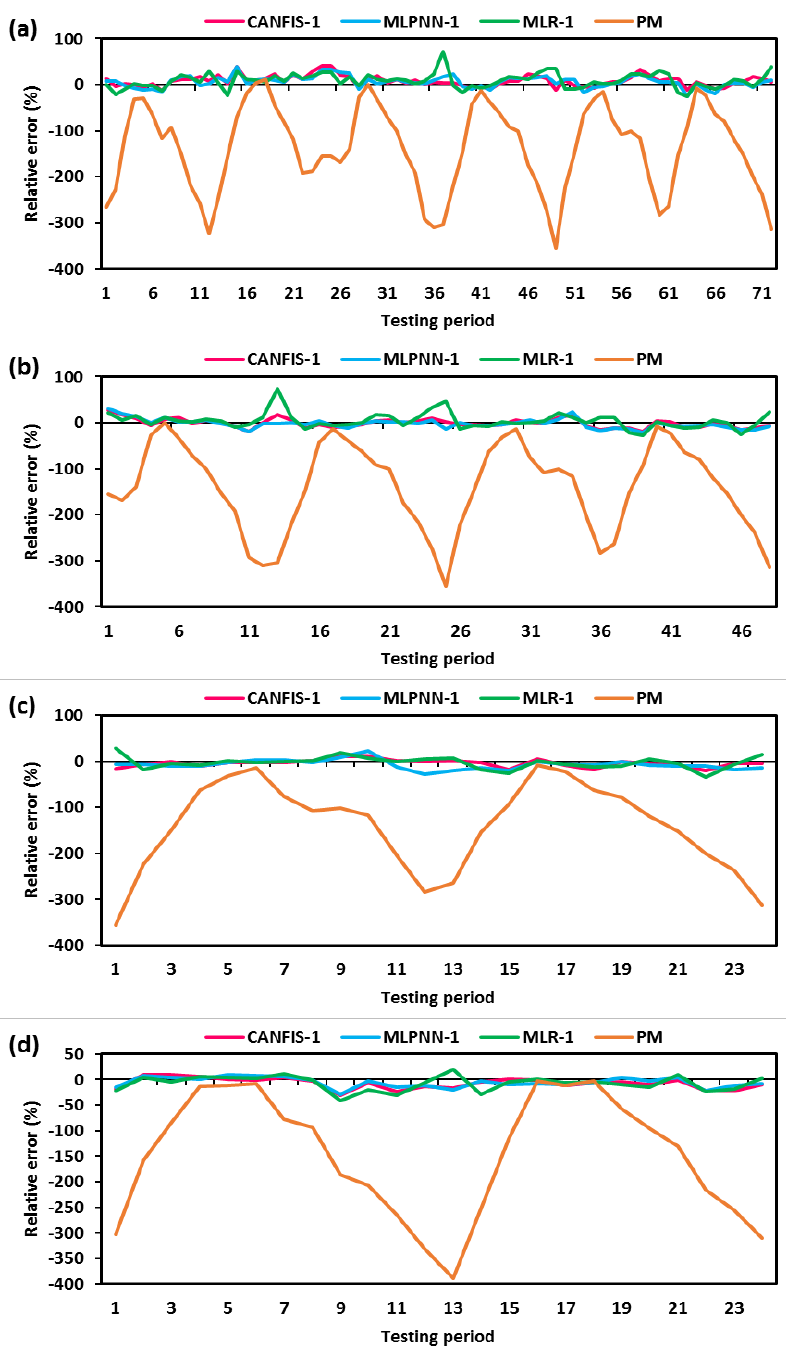
Figure 8. Relative error (RE) percentage distribution of the CANFIS-1, MLPNN-1, MLR-1, and PM models for ( a ) scenario-1, ( b ) scenario-2, ( c ) scenario-3, and ( d ) scenario-4 during the testing period at Pantnagar station.